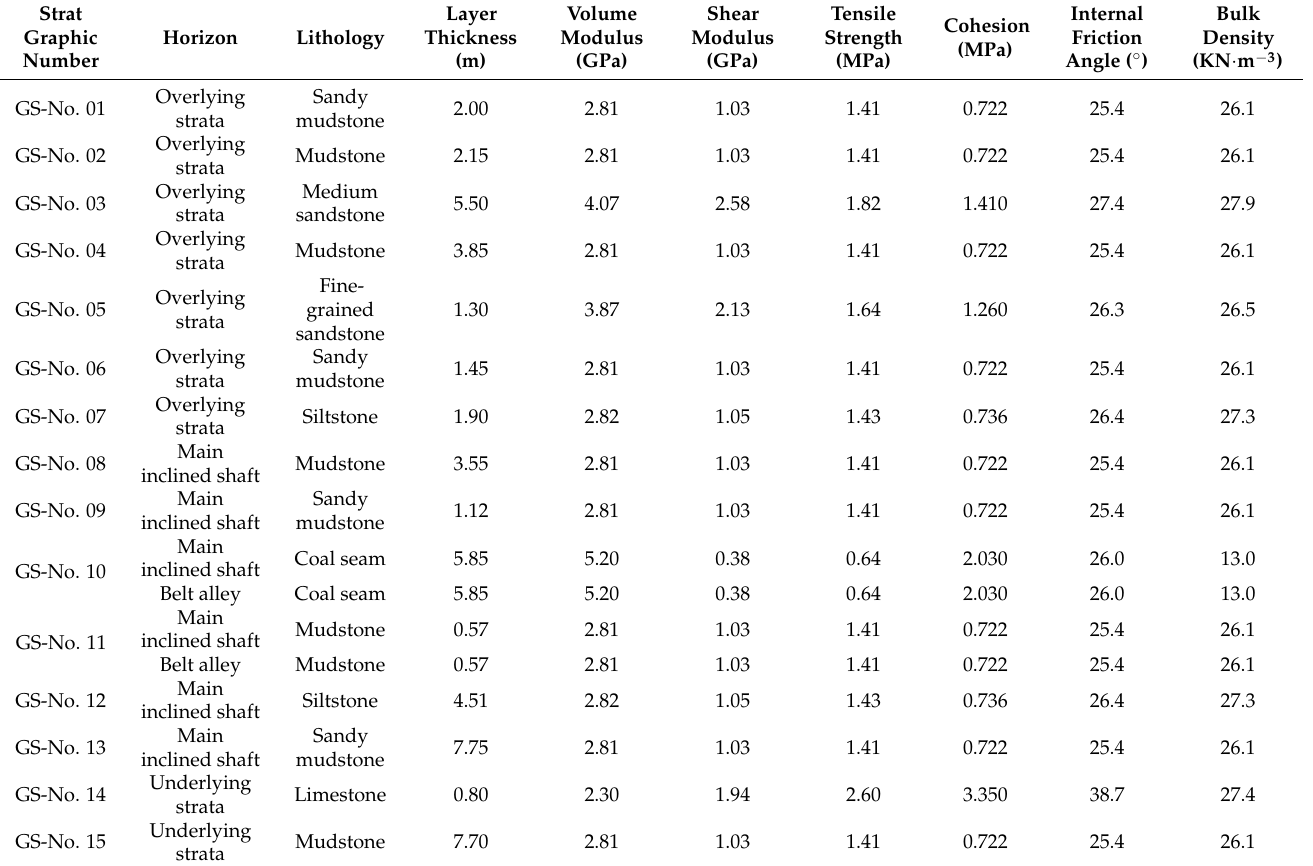
Table 1. Basic parameters of rock strata in shaft, roadway and chamber roof and floor.